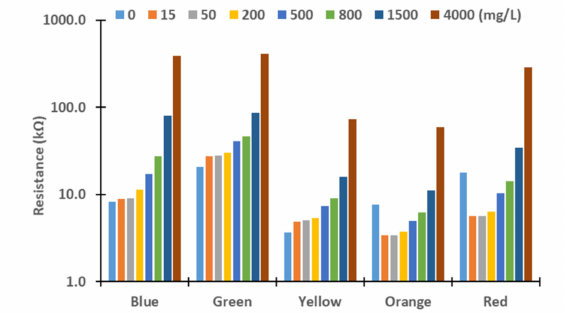
Figure 8. Measured resistance values for mixture 40% sediment and 60% algae.